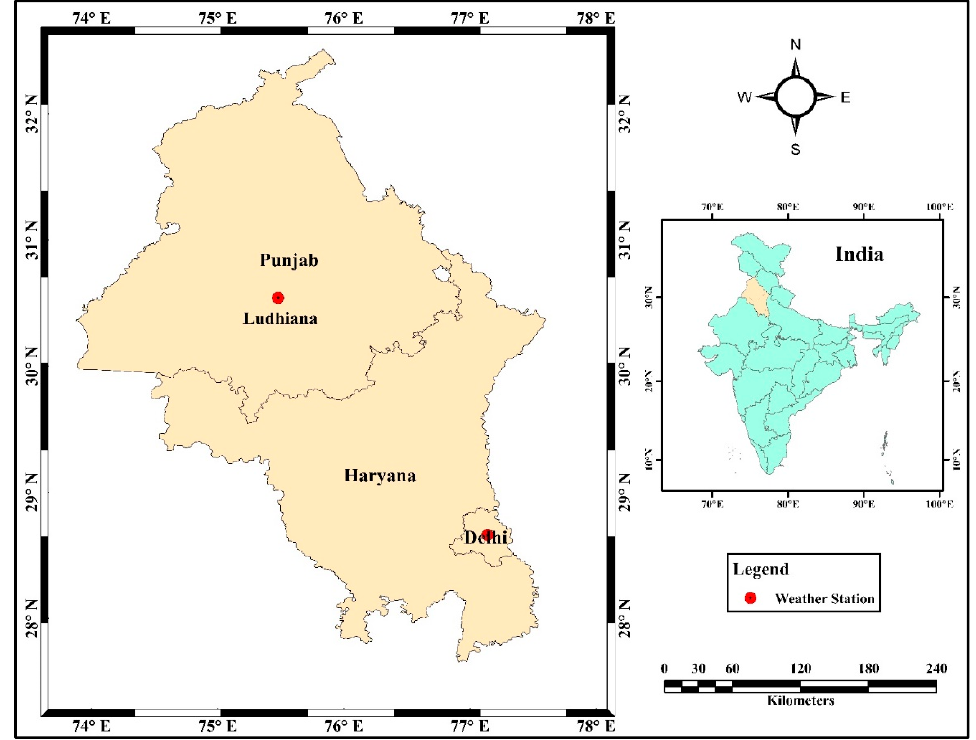
Figure 1. Location map of the study stations. Table 1. Detailed description of the study stations.